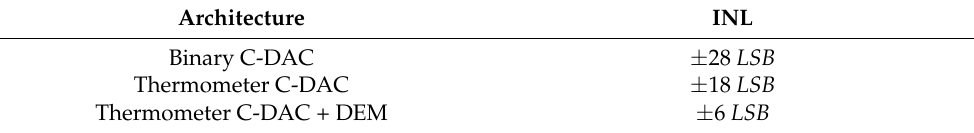
Figure 13. INL simulations using MATLAB for a 15-bit thermometer-coded C-DAC with and with- out DEM. Table 1. ADC performance summary considering a 2% mismatch for each unit capacitor.